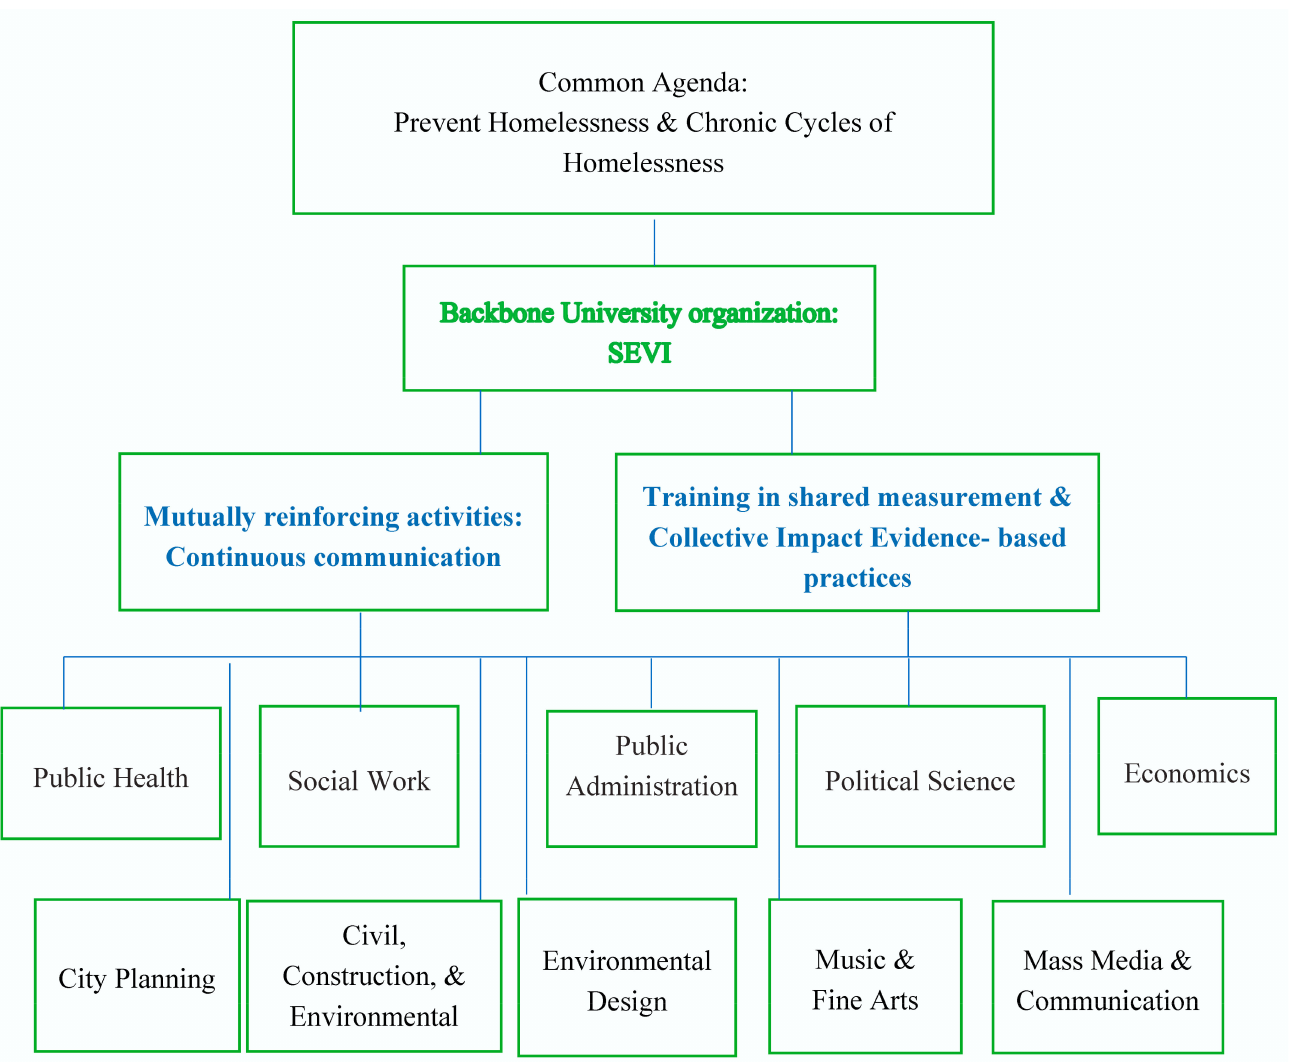
Figure 1. Three components of an interdisciplinary collective impact academic-practice